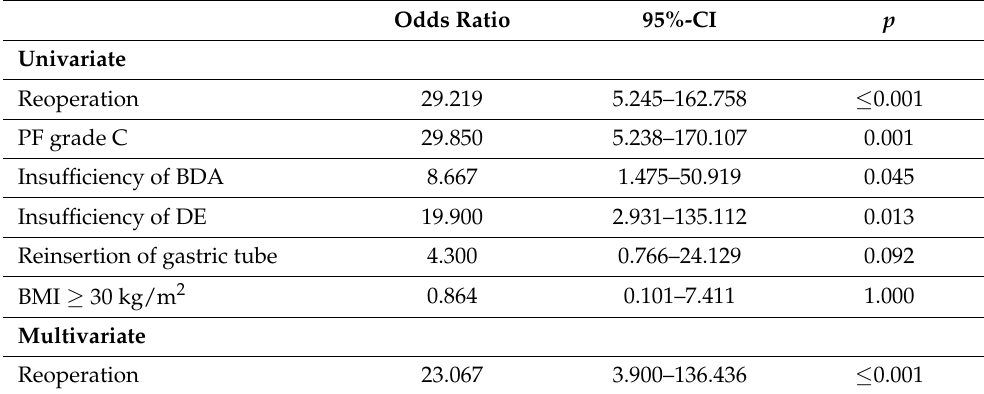
Table 5. Risk factors associated with high